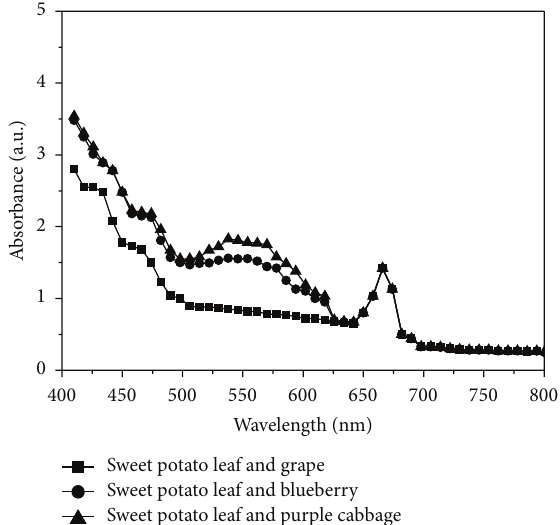
Figure 4: The absorption spectra for extracts of the cocktail dyes.